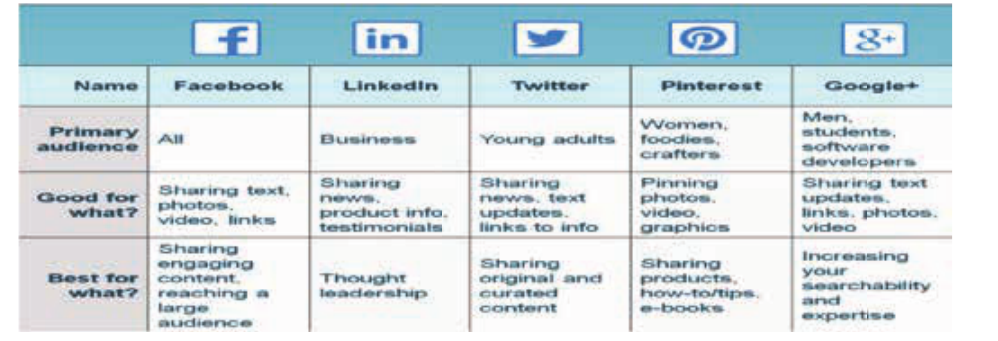
Table 1: Prominent Social Media Sites with Primary Audience and